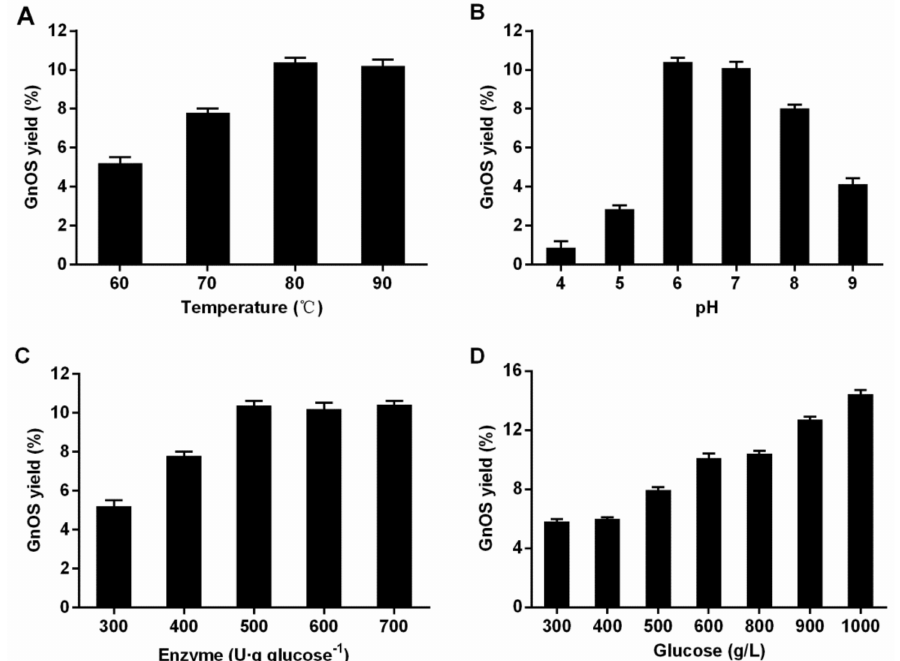
Figure 4. Effects of reaction parameters and substrate concentration on GnOS yield. ( A ) effect of reaction temperature on GnOS yield. ( B ) effect of reaction pH on GnOS yield. ( C ) effect of enzyme amount on GnOS yield. ( D ) effect of substrate concentration on GnOS